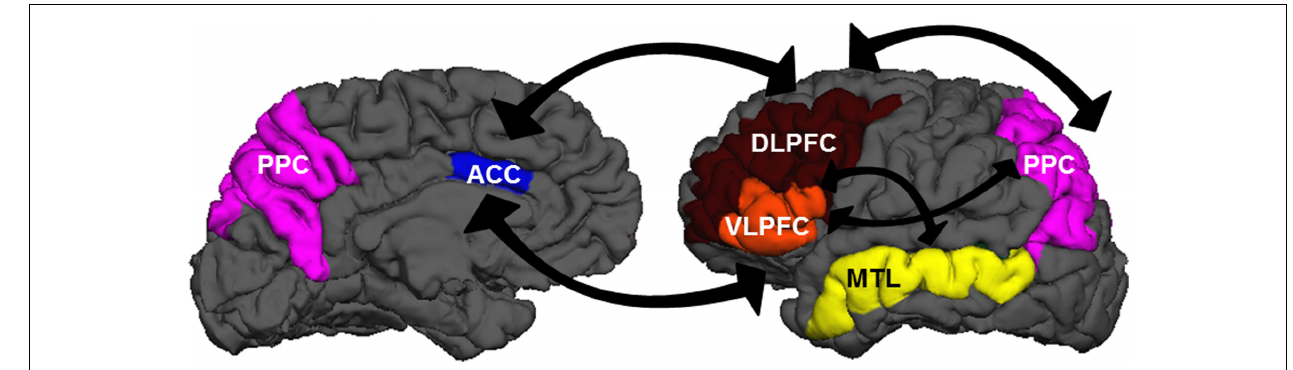
FIGURE 1 |A wide network of brain regions is recruited during EC processes. The panels above show medial (left) and lateral (right) views of the left hemisphere. Regions in the EC network include dorsolateral prefrontal cortex (DLPFC: brown), ventrolateral prefrontal cortex (VLPFC: orange),